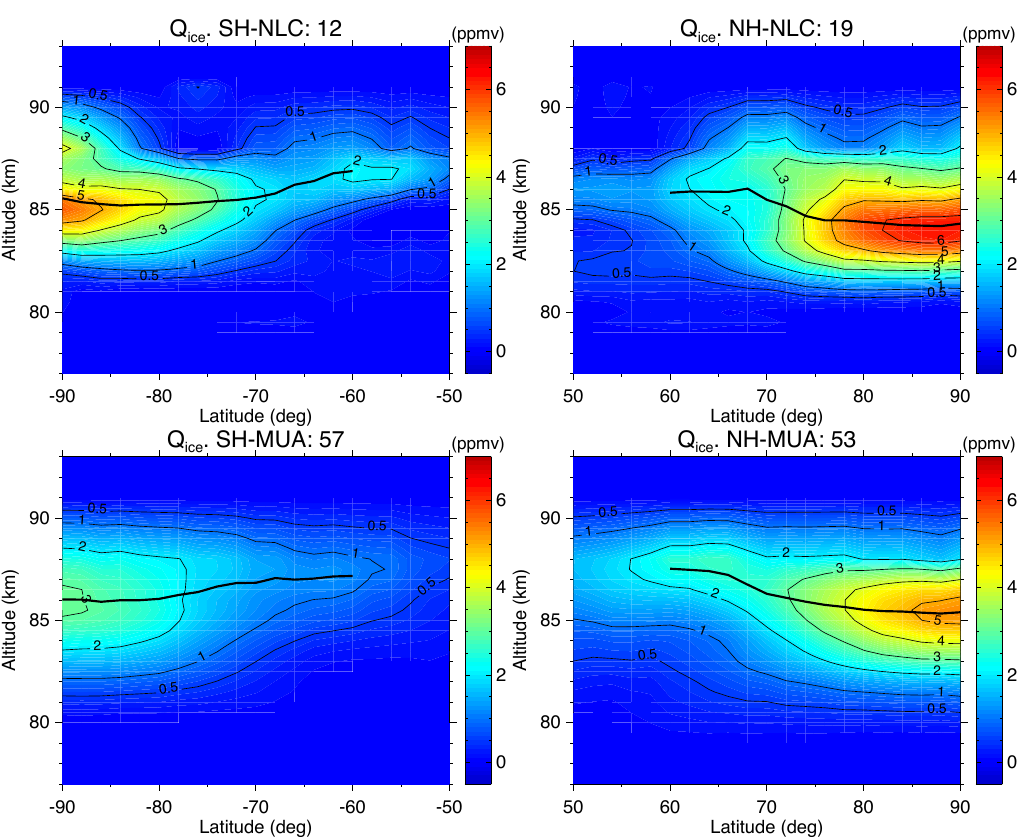
Figure 6. Same as Fig. 3 but in units ofppmv. The noise error of the H 2 O ice concentration plotted here, estimated by the standard error of the mean, is about 0.08 and 0.04ppmv for the NLC and MUA measurements, respectively. Mean altitudes of the ice layer. (SH)